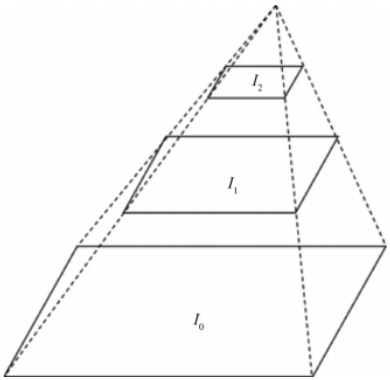
Figure 4. Image pyramid conceptual structure diagram.